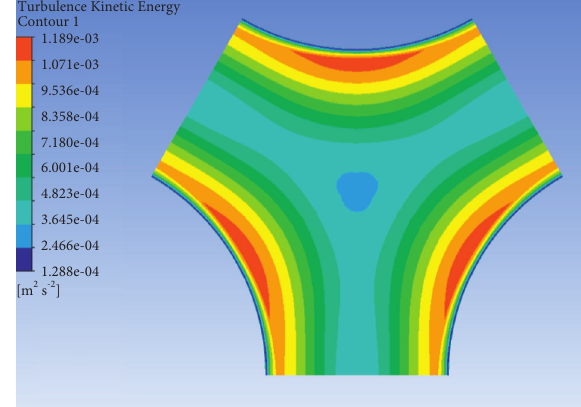
Figure 8: Turbulence kinetic energy distribution.